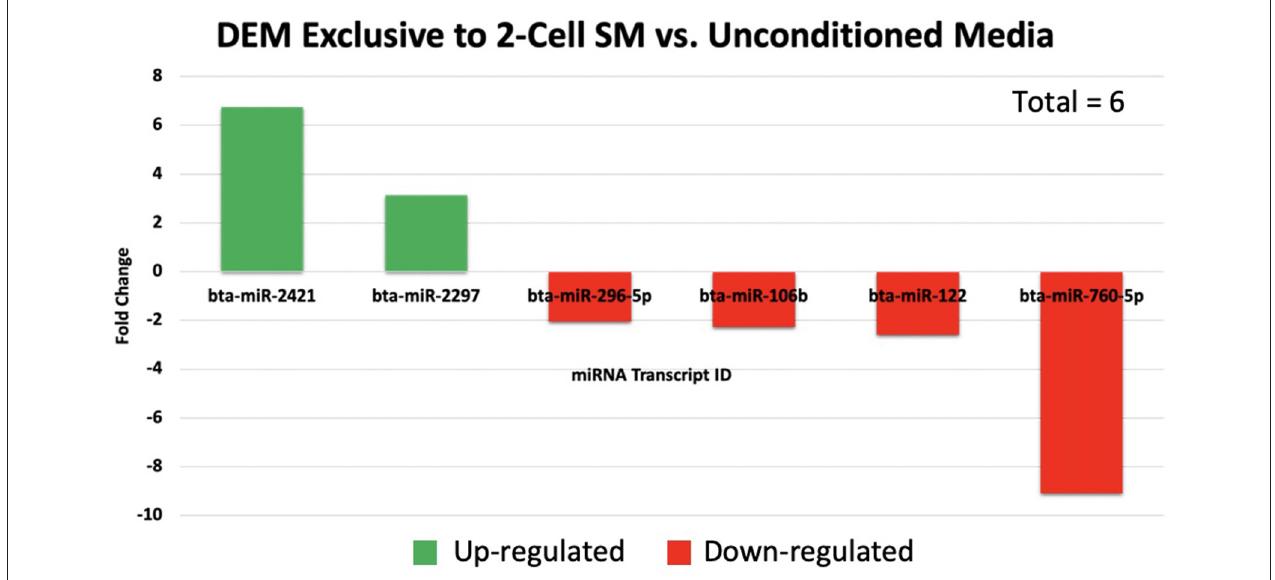
FIGURE 4 | The top 20 of 53 significantly up-regulated miRNAs are graphed with the 3 significantly down-regulated miRNAs exclusive to blastocyst spent media.